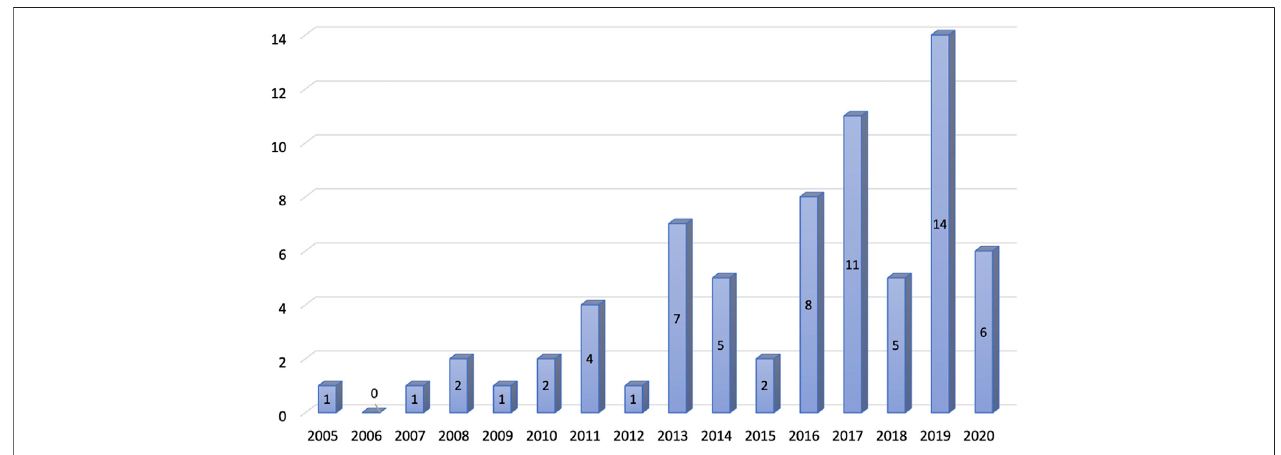
FIGURE 2 | Trends in the publications of real-world based cost-effectiveness analysis.